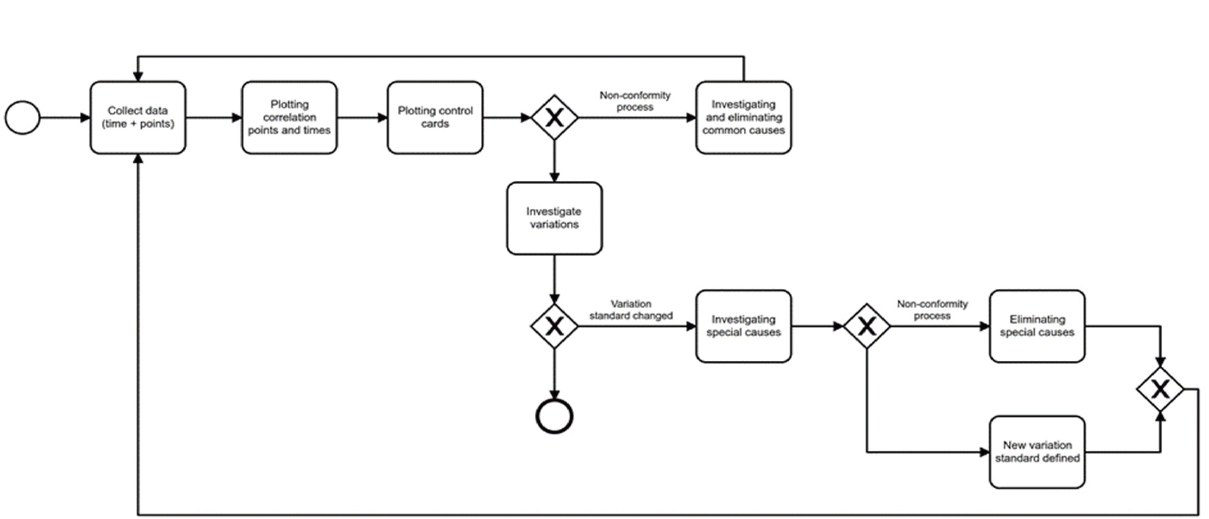
Figure 1. Process improvement flow with